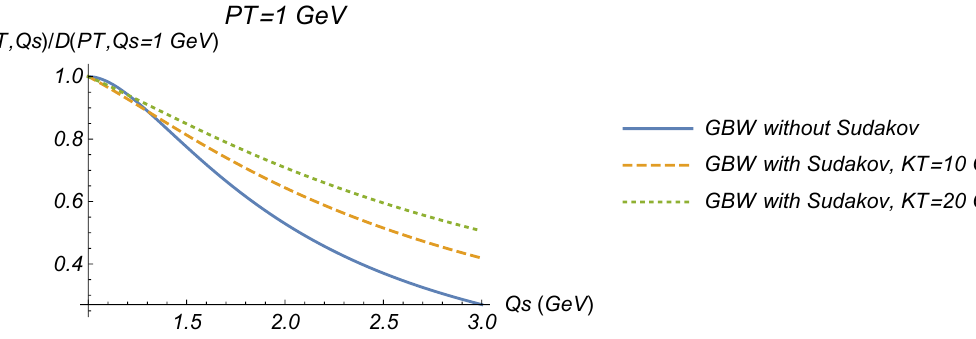
Figure 4 . Eq. (5.1) (solid blue line), eq. (5.2) with eq. (5.2) with versus Q s , for